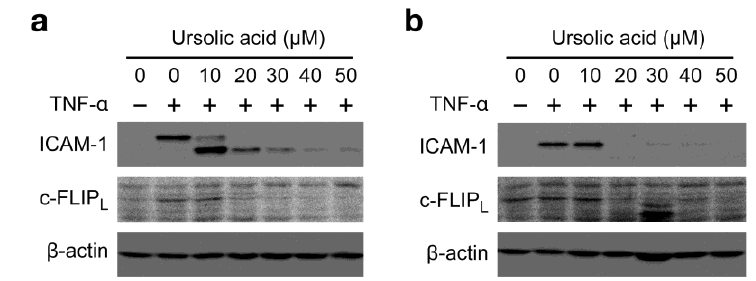
Figure 5. Ursolic acid inhibits TNF-α-induced protein expression of ICAM-1 and c-FLIP ( a and b ) HT-1080 cells ( a ) and MCF7 cells ( b ) were preincubated with various concentrations of ursolic acid for 1 h and then incubated with (+) or without (–) TNF-α (2.5 ng/mL) for 6 h in the presence or absence of ursolic acid. Protein expression of ICAM-1 and c-FLIP was analyzed by Western L